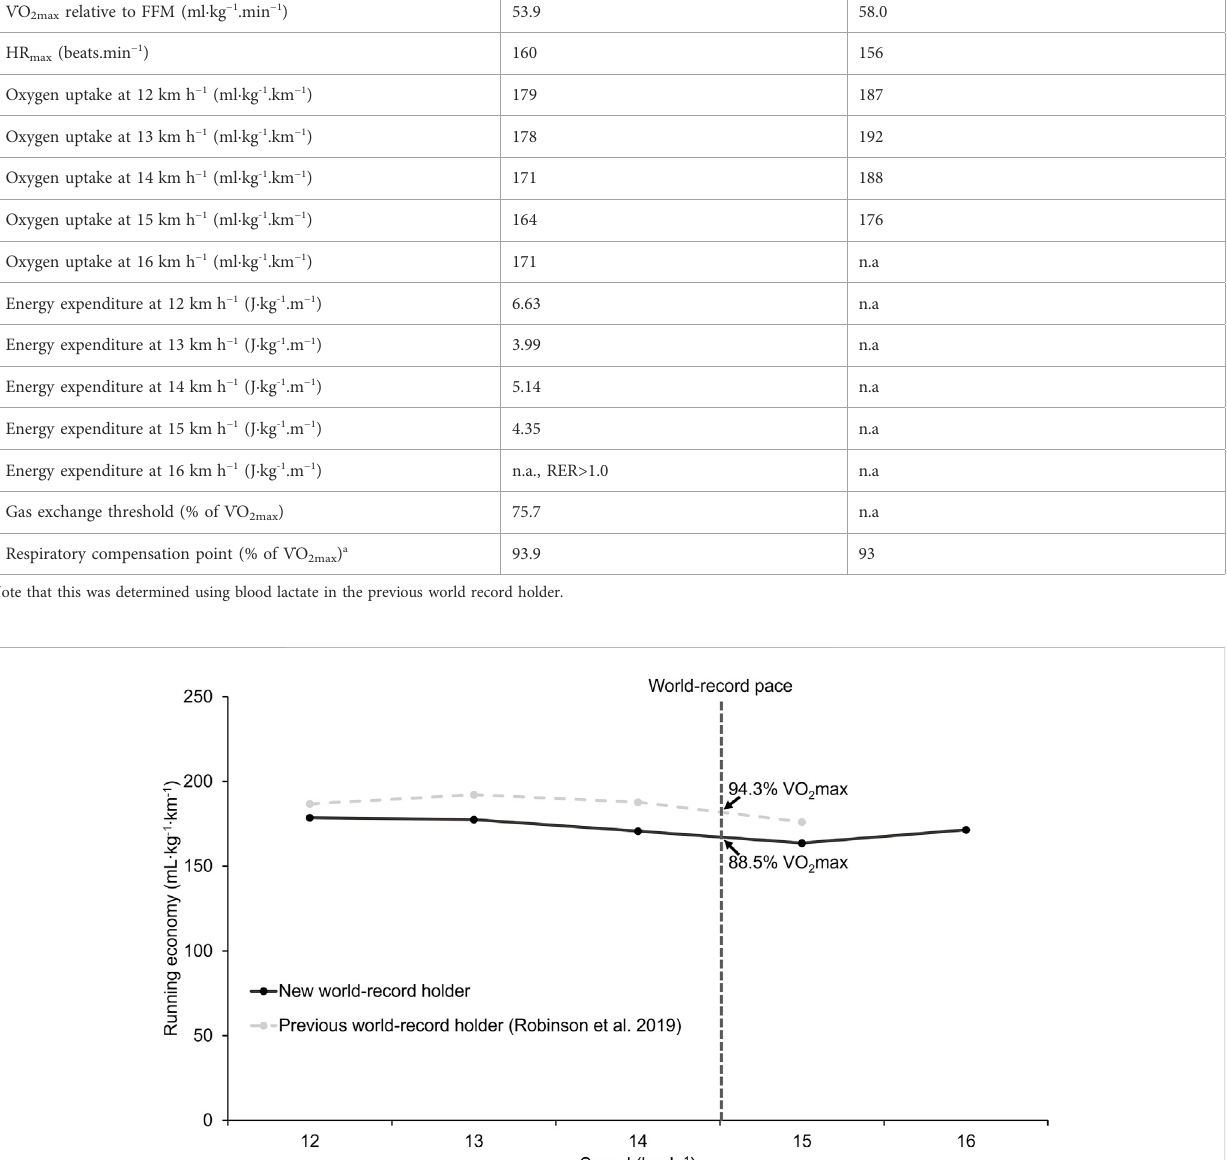
oxygen uptake at the world record pace was 41.3 ml kg − 1 · min − 1 , _ corresponding to 88.5% of the VO 2 max. Vastus lateralis fi ber content was 90.3% type I and 9.7% type II myosin heavy chain